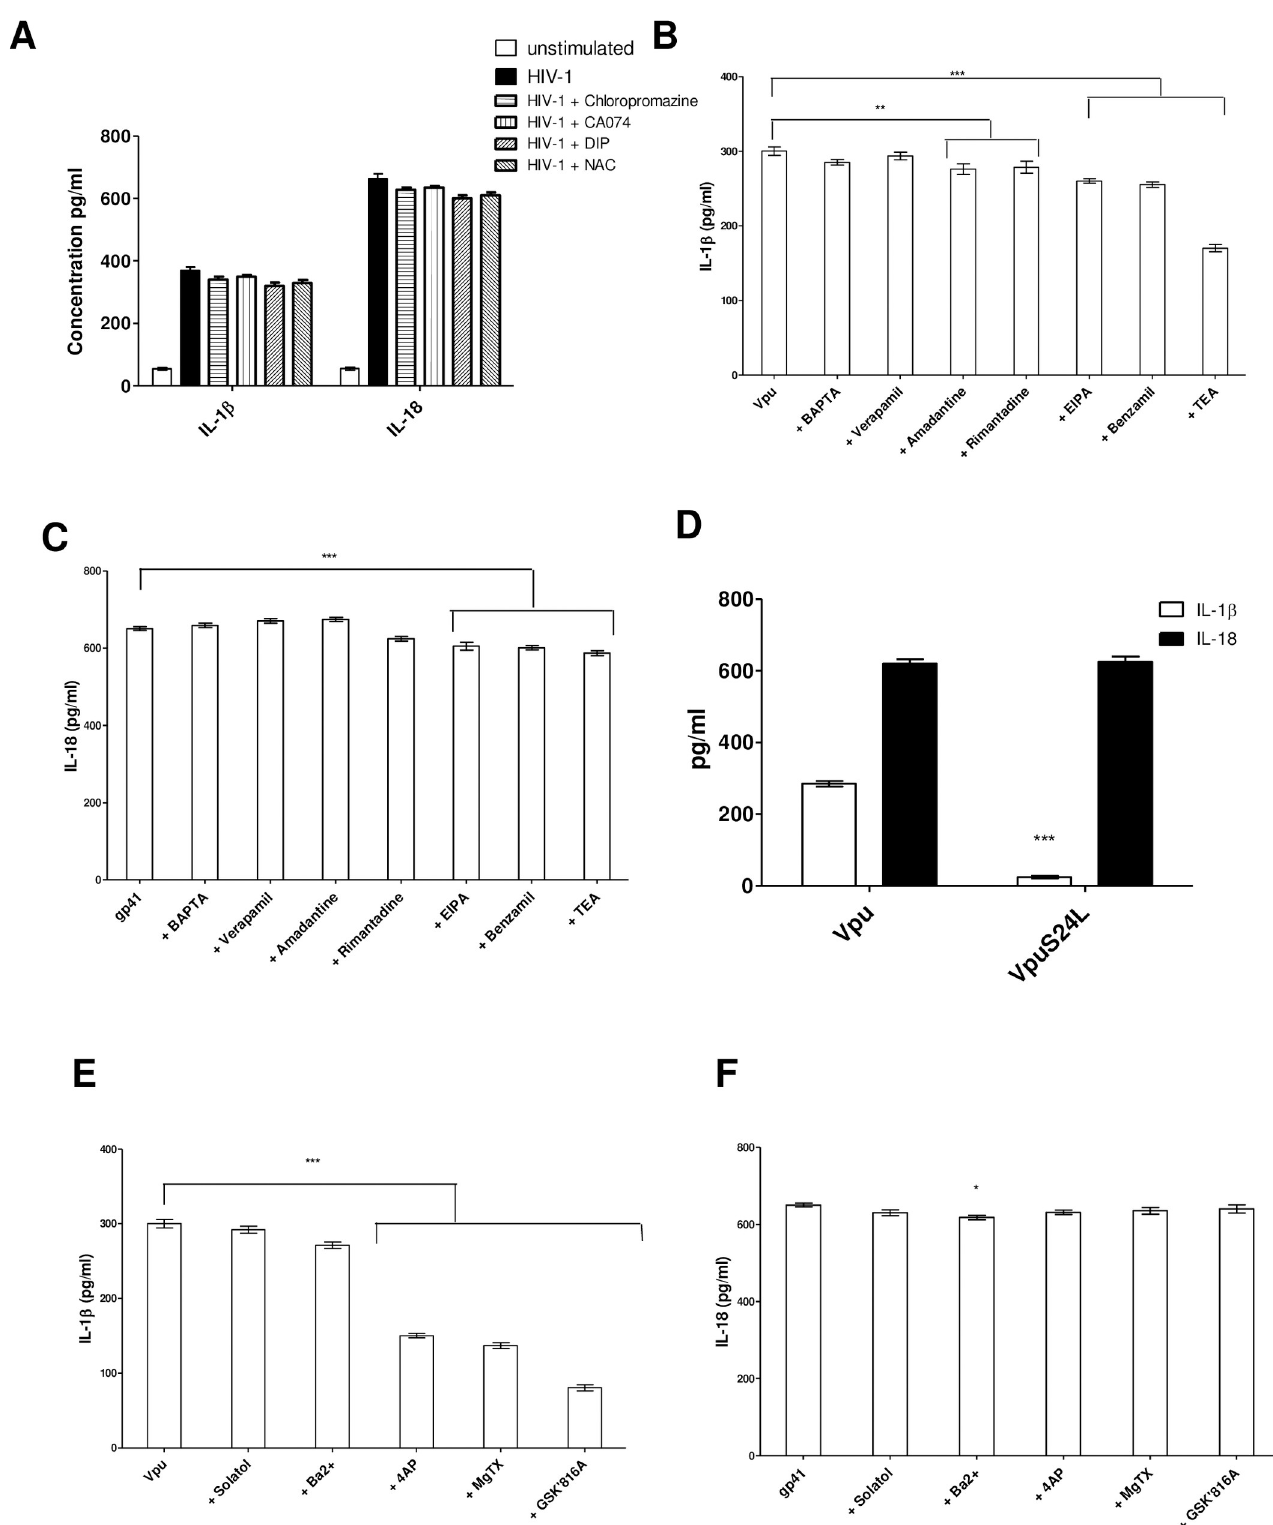
Fig 3. Monovalent Ion channel inhibitors reduce IL-1 β dependent inflammasome activation. Monocyte derived macrophages (MDMs) (1 x 10 6 ) were infected with HIV-1 (MOI = 1) for 12 hr were also cultured in the presence or absence of Cathepsin B inhibitor (CA-074) (100 μ M), DPI (20 μ M), NAC (20mM)